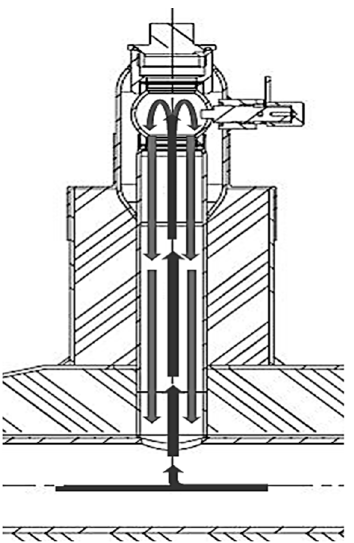
Figure 8. Expected convective water movements in a drainage valve.